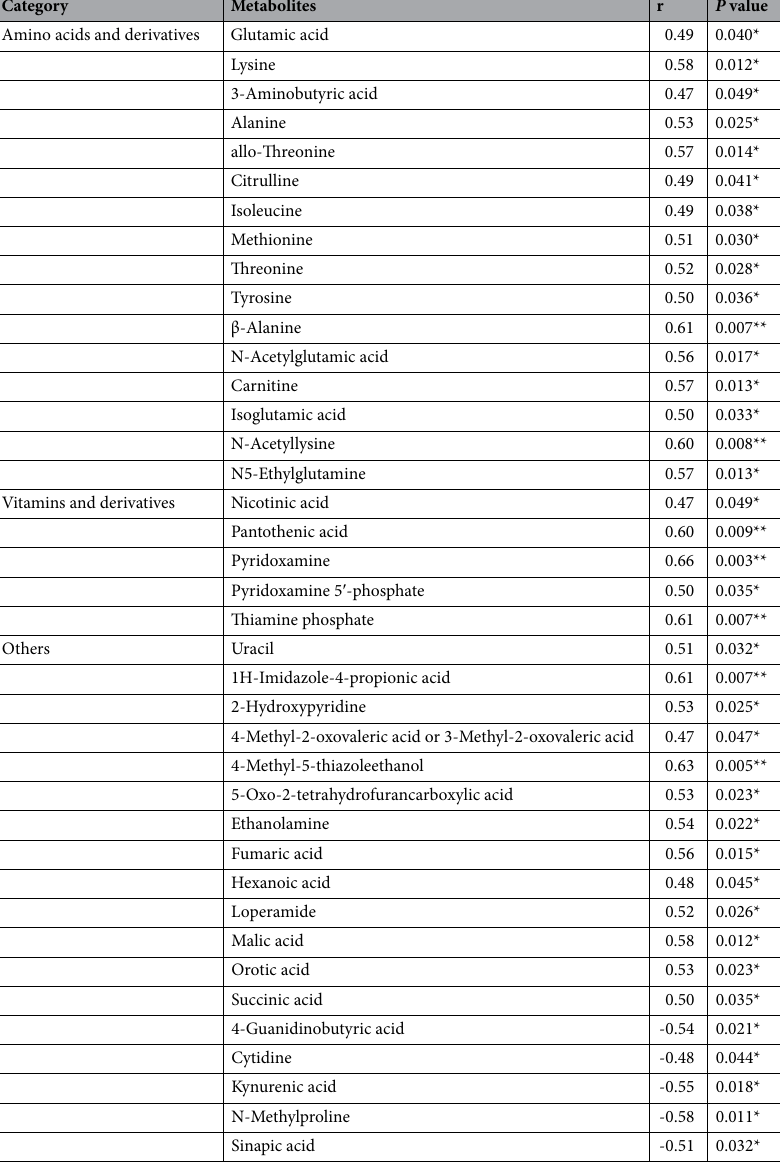
Table 2. Significant correlation between fecal Crps and metabolites. * P < 0.05, ** P <